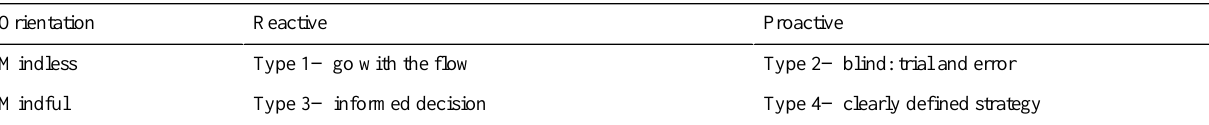
Table 3. Reactive/proactive and mindless/mindful social media strategies enactment.